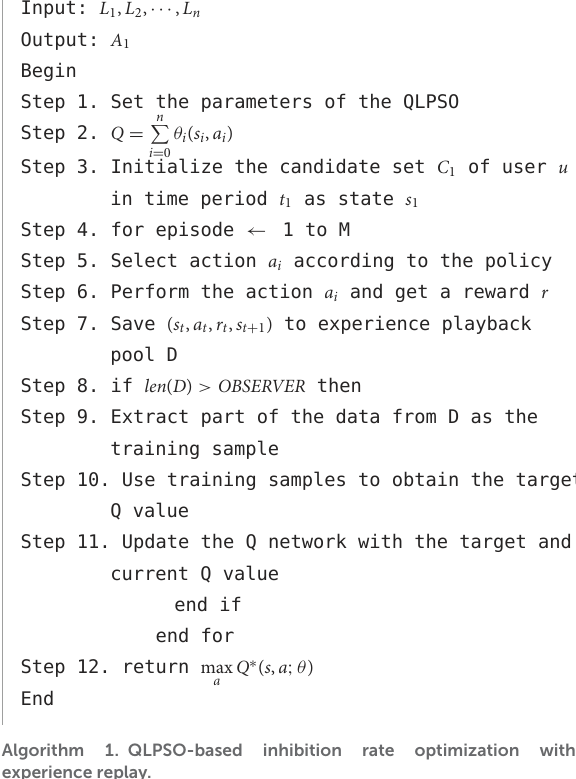
Algorithm 1. QLPSO-based inhibition rate optimization with experience replay.